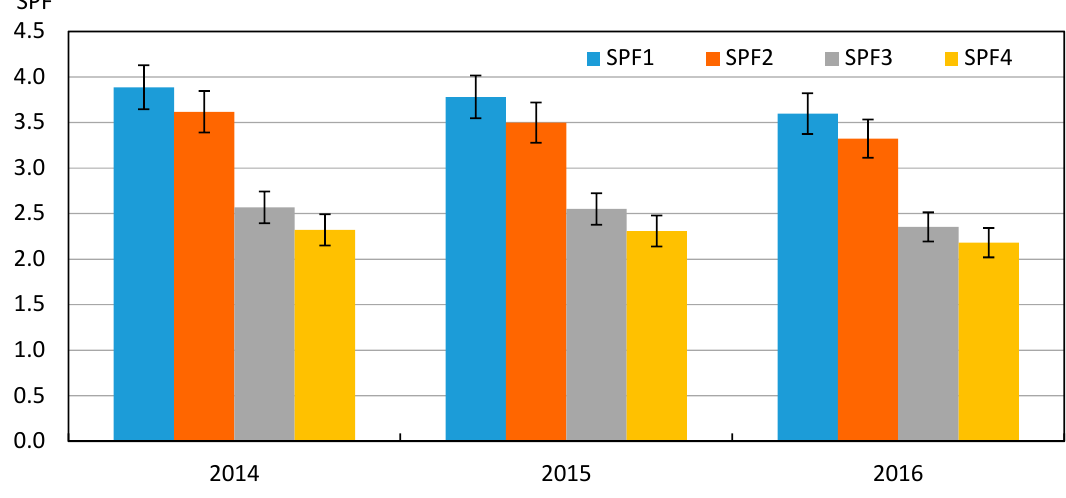
Figure 19. Annual SPF values based on SEPEMO boundaries.